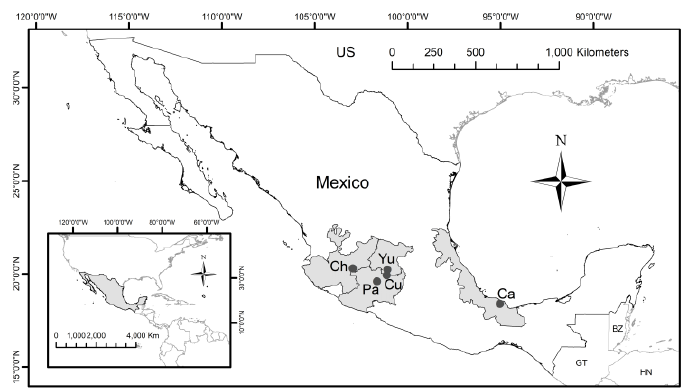
Figure 1. Regions and locations of the studied lakes in Mexico. Ch: Chapala, Cu: Cuitzeo, Pa: Pátzcuaro, Yu: Yuriria, Ca: Catemaco.